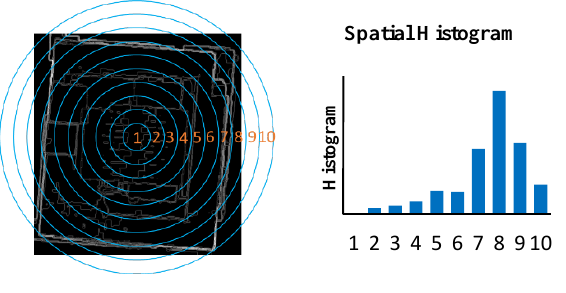
Figure 5. Result of eigen-feature.